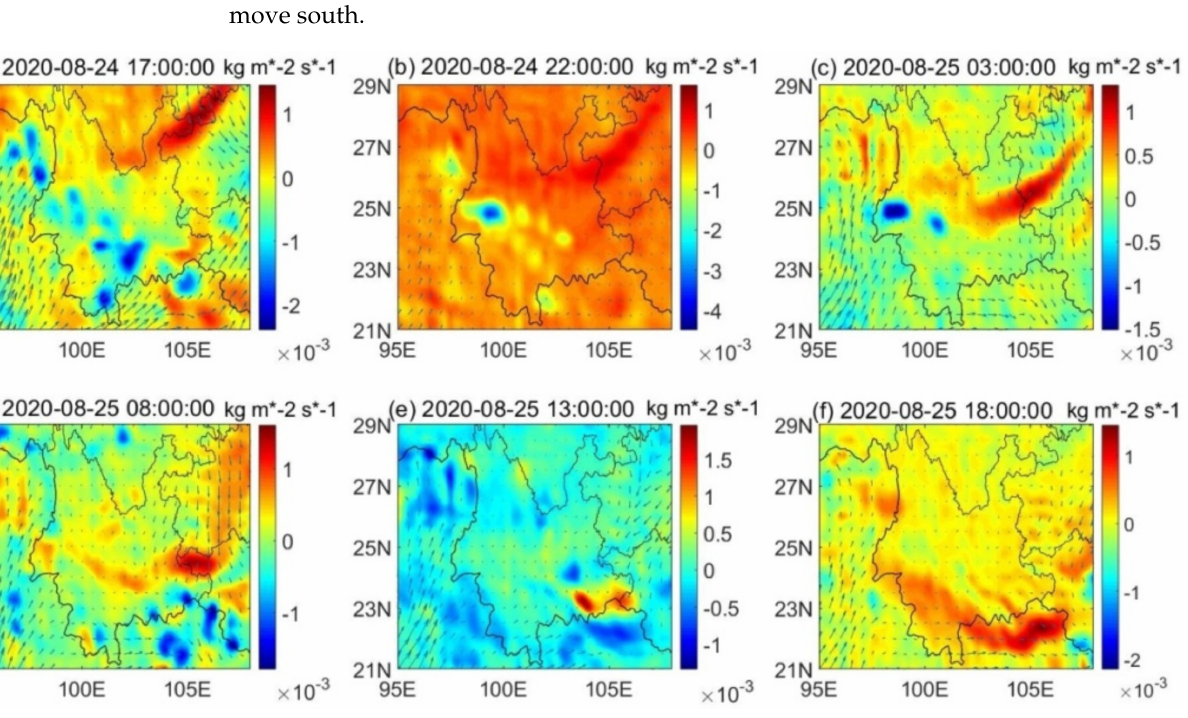
Figure 10. The combination of ∇ p and 850 hPa wind field in Yunnan–Guizhou Plateau from 17:00 on 24 August 2020 (UTC) to 18:00 on 25 August 2020 (isosurface represents ∇ p , unit: kg m − 2 s − 1 ; the direction of the arrow represents the wind direction, and the length represents the wind speed. ( a – f ) represent the results of 5 h